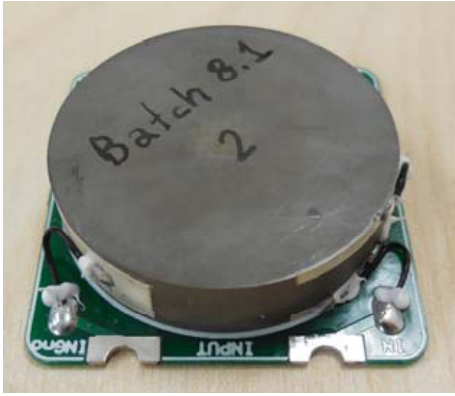
Figure 18. Isolated piezoelectric radial transformer for use in AC-DC converter for universal input voltage operation (85–265 W) and 24V, 40 W output load (Courtesy of Micromechatronics, Inc.).